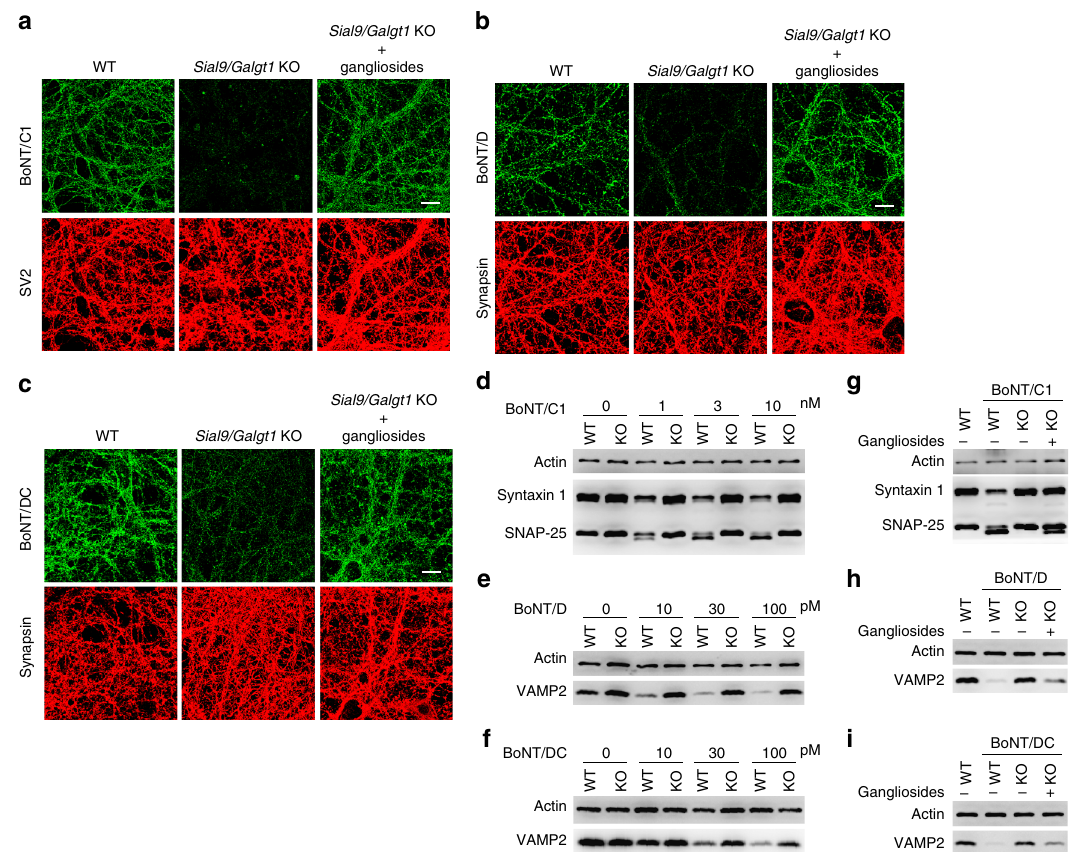
Fig. 3 Depleting all gangliosides in Sial9/Galgt1 double-KO neurons reduced binding and entry of BoNT/DC. a – c Binding of BoNT/C1 ( a ), BoNT/D-H C ( b ), and BoNT/DC-H C ( c ) to WT, Sial9/Galgt1 double-KO, and Sial9/Galgt1 double-KO neurons pre-loaded with exogenous gangliosides were examined by immuno fl uorescence staining, under the same assay conditions described in Fig. 1b – d. Binding of BoNT/C1 and BoNT/D-H C was abolished in Sial9/Galgt1 double-KO neurons. Binding of BoNT/DC-H C was reduced in Sial9/Galgt1 double-KO neurons. Exogenous gangliosides restored binding of all three toxins to Sial9/Galgt1 double-KO neurons. d – f WT and Sial9/Galgt1 double-KO neurons were exposed to BoNT/C1 ( d ), BoNT/D ( e ), or BoNT/DC ( f ) at the indicated concentrations. Cell lysates were analyzed by immunoblot as described in Fig. 1e – g. Entry of BoNT/C1 and BoNT/D into Sial9/Galgt1 double-KO neurons was largely blocked, as there was a lack of cleavage of SNAP-25 and syntaxin 1 ( d ), and VAMP2 ( e ). BoNT/DC still entered Sial9/Galgt1 double- KO neurons and cleaved VAMP2, but the levels of VAMP2 cleavage were lower in Sial9/Galgt1 double-KO neurons than in WT neurons ( f ), indicating that entry of BoNT/DC was reduced in Sial9/Galgt1 double-KO neurons compared to WT neurons. g – i Pre-loading exogenous gangliosides onto Sial9/Galgt1 double-KO neurons restored functional entry of BoNT/C1 (10 nM, g ), BoNT/D (100 pM, h ), and BoNT/DC (100 pM, i ), analyzed by immunoblot as described in Fig. 1e – g. One of two ( a – c ) or three ( d – i ) independent experiments is